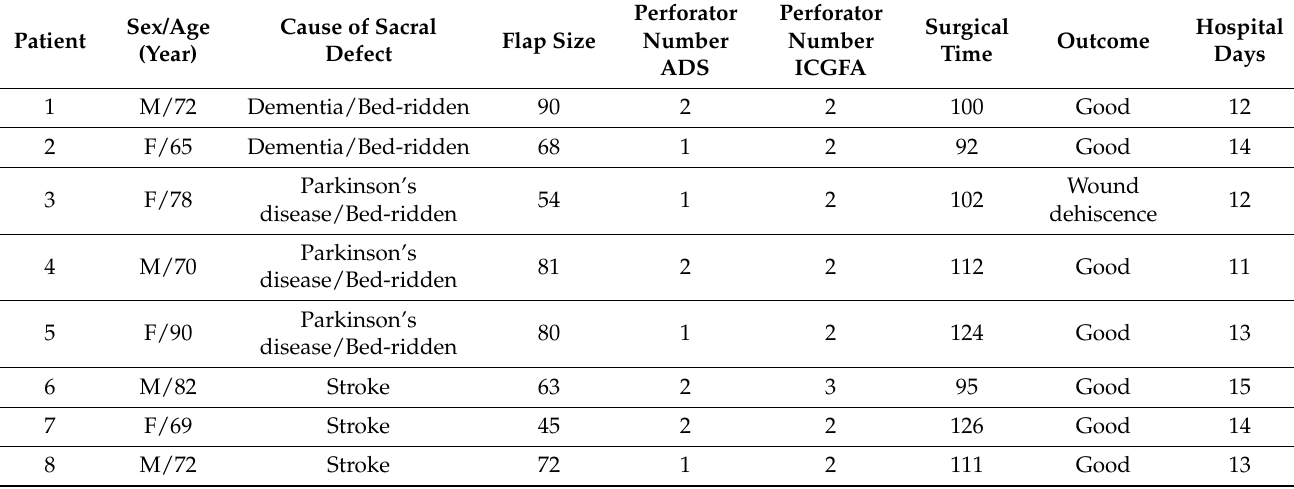
Table 4. Group 2 (ADS and